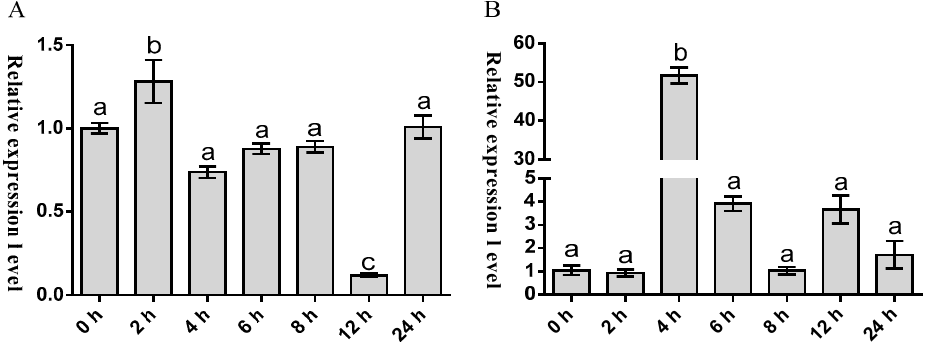
Figure 5. Temporal expression analysis of Malitaf ( A ); and Matnf α ( B ) mRNA in spleen from M. amblycephala after LPS stimulation. Significant pairwise expression-level differences among different time-points are indicated by different letters above the bars.